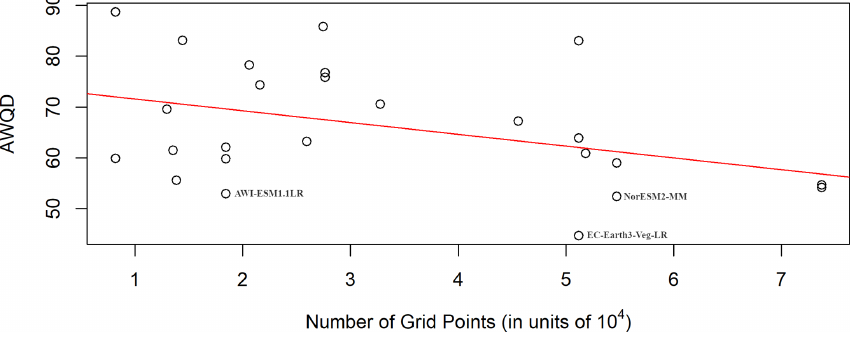
Figure 8. The average weighted quantile difference (AWQD) of the 27 CMIP6 models considered plotted against the model resolution (number of model grid points in units of 10 4 ). The linear regression line (intercept 73 . 310, slope − 2 . 368) is shown in red.